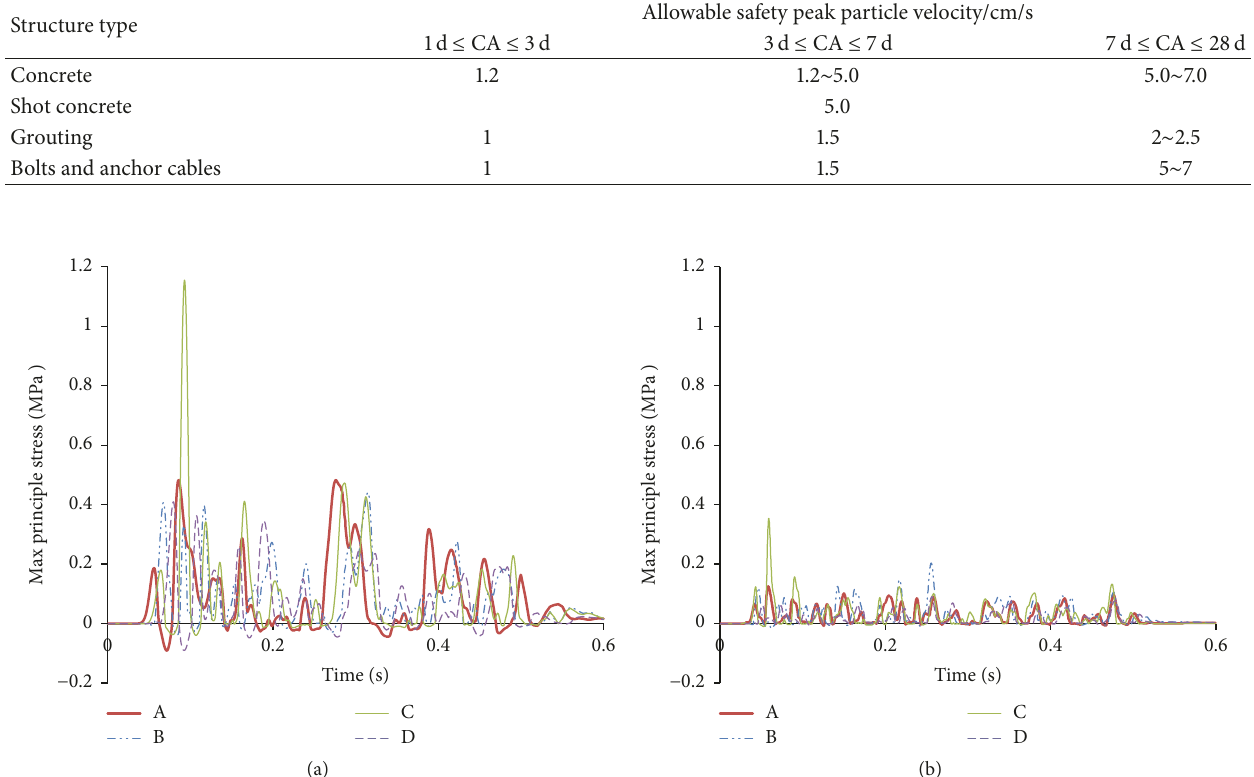
Figure 11: Maximum principle stress response on monitoring points induced by full-face blasting (a) and CD method (b).